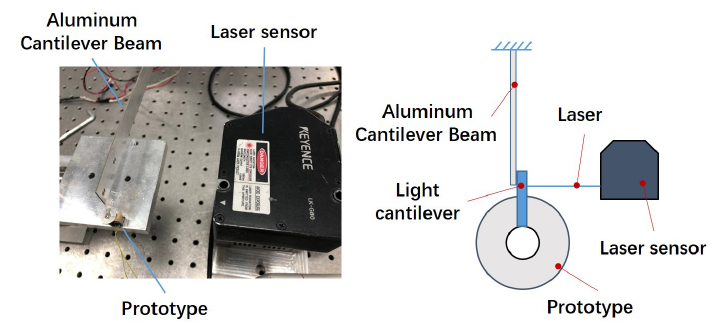
Figure 18. Measuring principle of output torque.